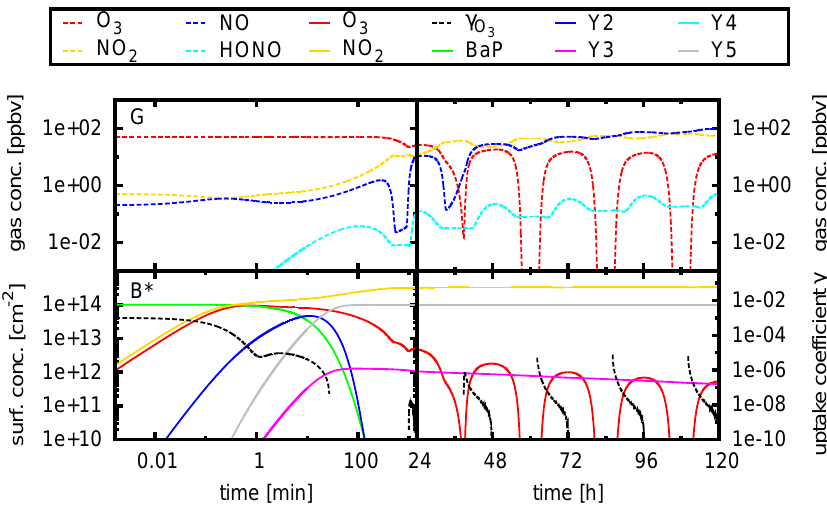
Fig. 4. The temporal evolution of gas-phase component concentrations ( G ), surface component concentrations, and uptake coefficients for scenario B ∗ are shown and plotted on a logarithmic timescale for day one (left panels) and on a linear timescale for the four following days (right panels). Scenario B ∗ corresponds to scenario B with a 10-fold increase of the NO emission rates.